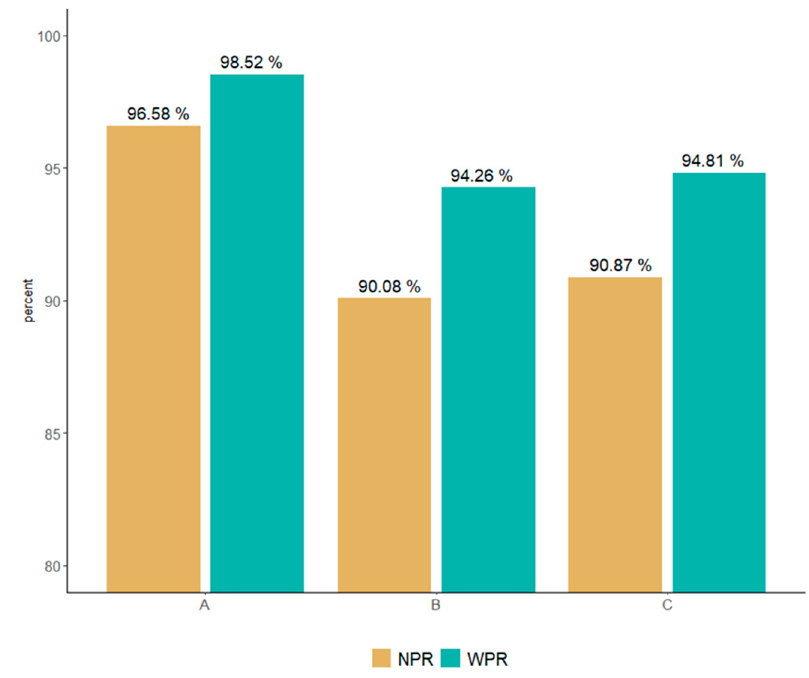
Figure 1. Comparison of NPR and WPR according to error and warning weights.